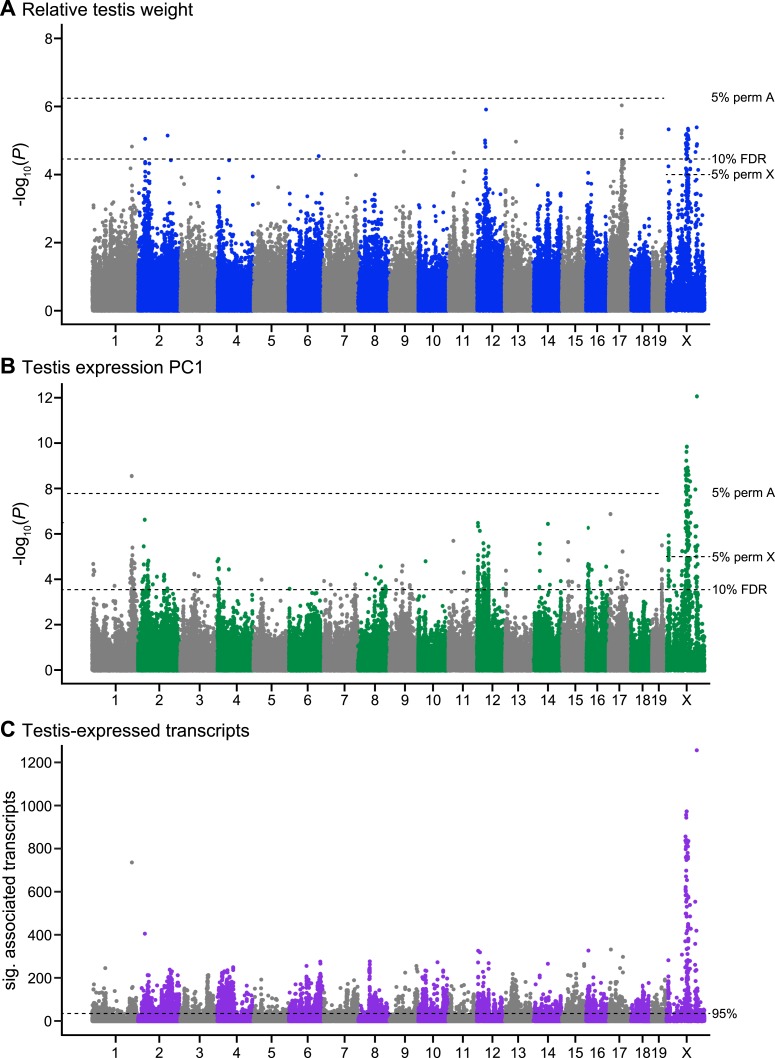
Manhattan plot of GWAS results.Single SNPs associated with (A) relative testis weight, (B) testis expression principal component 1, and (C) expression of transcripts located on other chromosomes (trans). Dashed lines indicate significance thresholds based on: permutations for autosomes (labeled 5% perm A), permutations for X chromosome (labeled 5% perm X), false discovery rate <0.1 (labeled 10% FDR), and 95th percentile of significant transcript association counts across SNPs (labeled 95%).DOI:
http://dx.doi.org/10.7554/eLife.02504.00510.7554/eLife.02504.006Figure 1—source data 1.SNPs significantly associated with relative testis weight and/or testis expression PC1 (excel file).